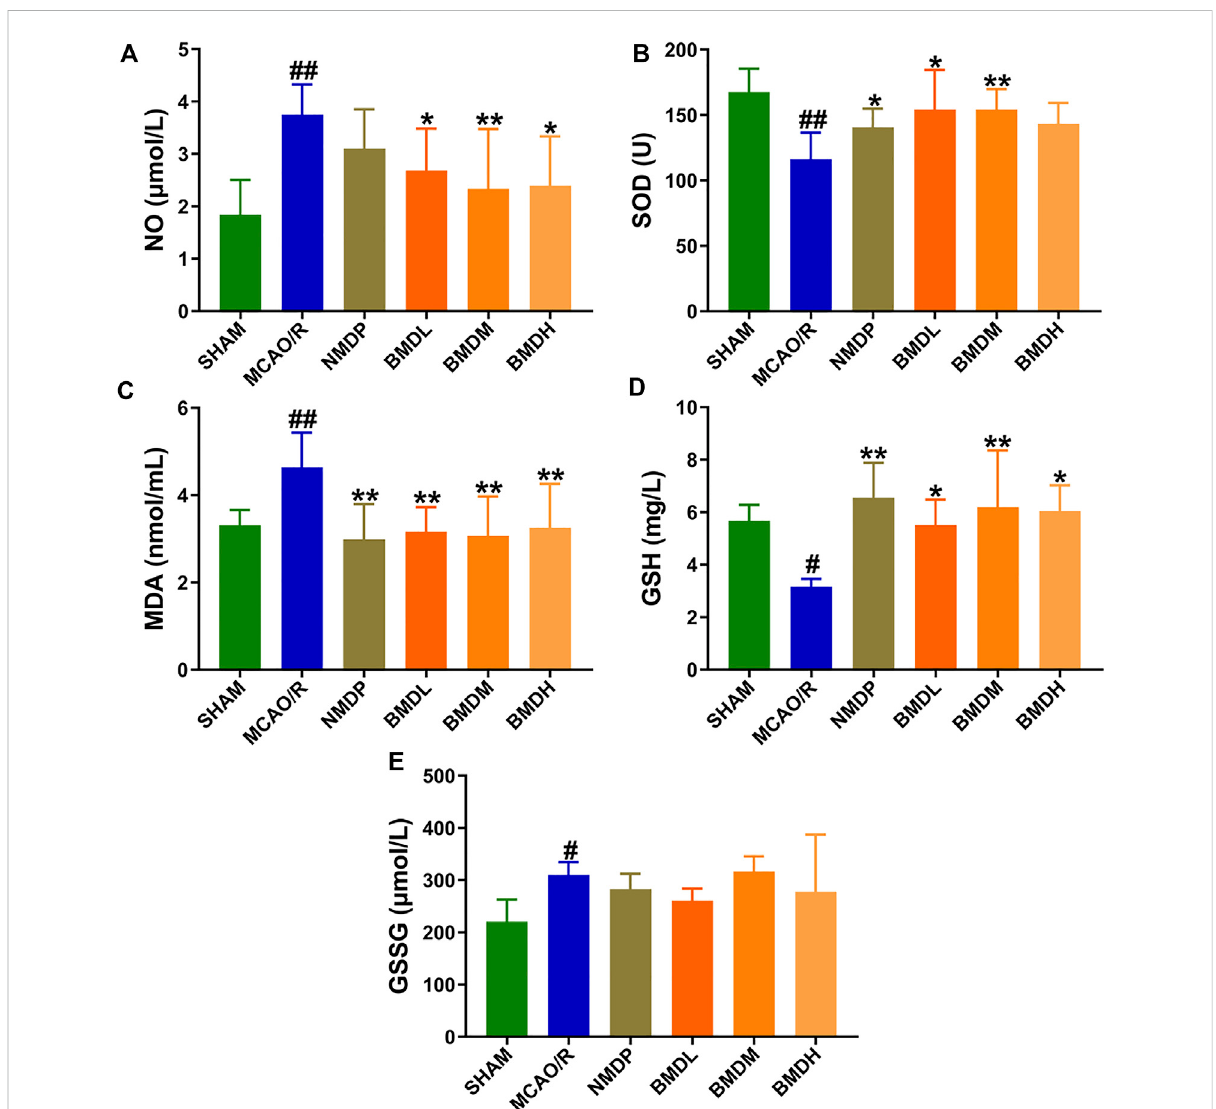
FIGURE 2 Effect ofBMD on themarkersofoxidative stress( n = 8)includingNO,SOD, MDA,GSH, andGSSG. (A) NO. (B) SOD. (C) MDA. (D) GSH. (E) GSSG. Data were expressed as the mean ± SD. *p < 0.05, **p < 0.01 relative to the MCAO/R group; # p < 0.05, ## p < 0.01 relative to the SHAM group.